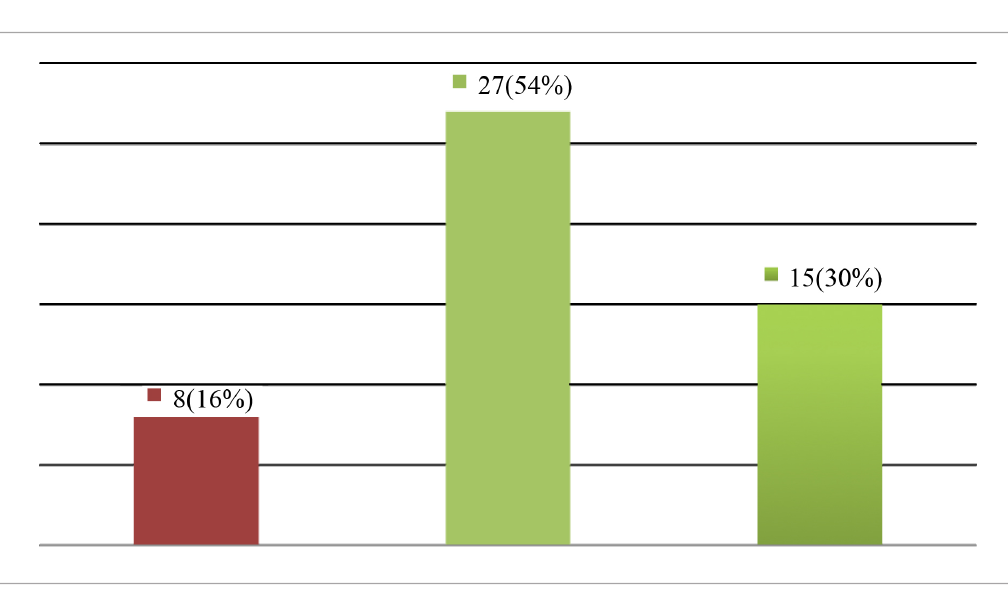
Figure 3: Distribution of Patients According to the Duration of vitiligo